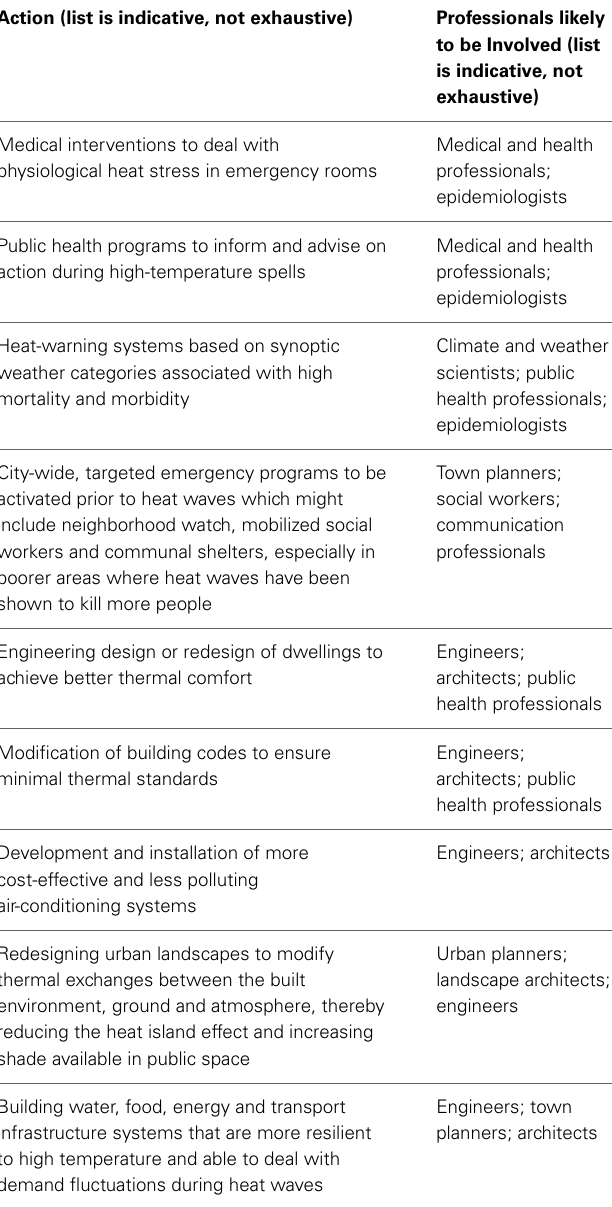
Table 1 | Examples of actions available to planners and policy-makers for tackling higher average temperatures and more frequent and/or more intense heat